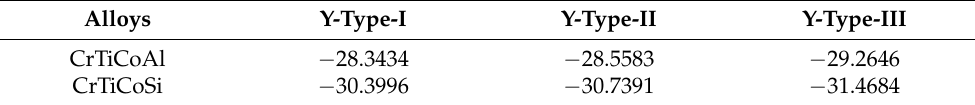
Table 2. Ground state energies of both compounds in the three atomic configurations, in eV. Alloys